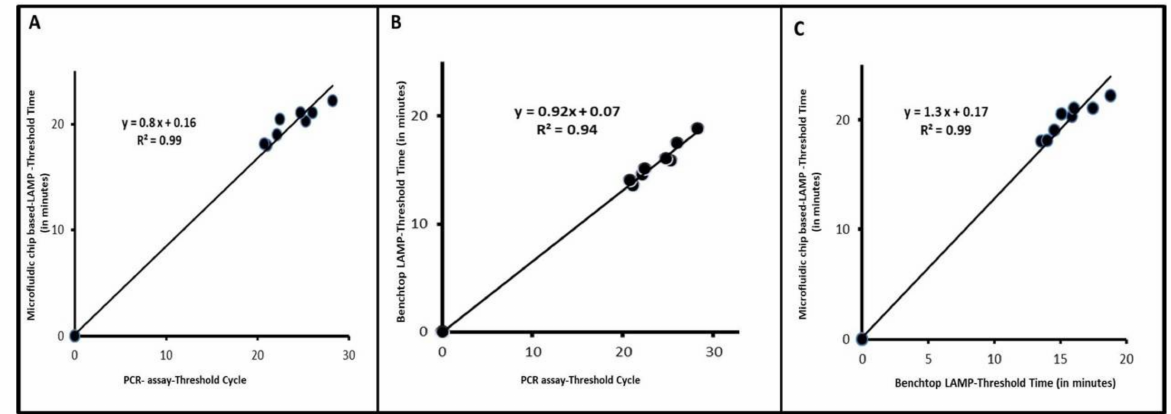
Figure 5. Clinical performance of our benchtop LAMP, benchtop PCR and microfluidic device when testing samples from diseased chickens ( A ) Microfluidic chip-threshold time as a function of PCR threshold cycle. ( B ) Benchtop LAMP threshold time as a function of PCR threshold cycle. ( C ) Microfluidic device threshold time as a function of benchtop LAMP threshold